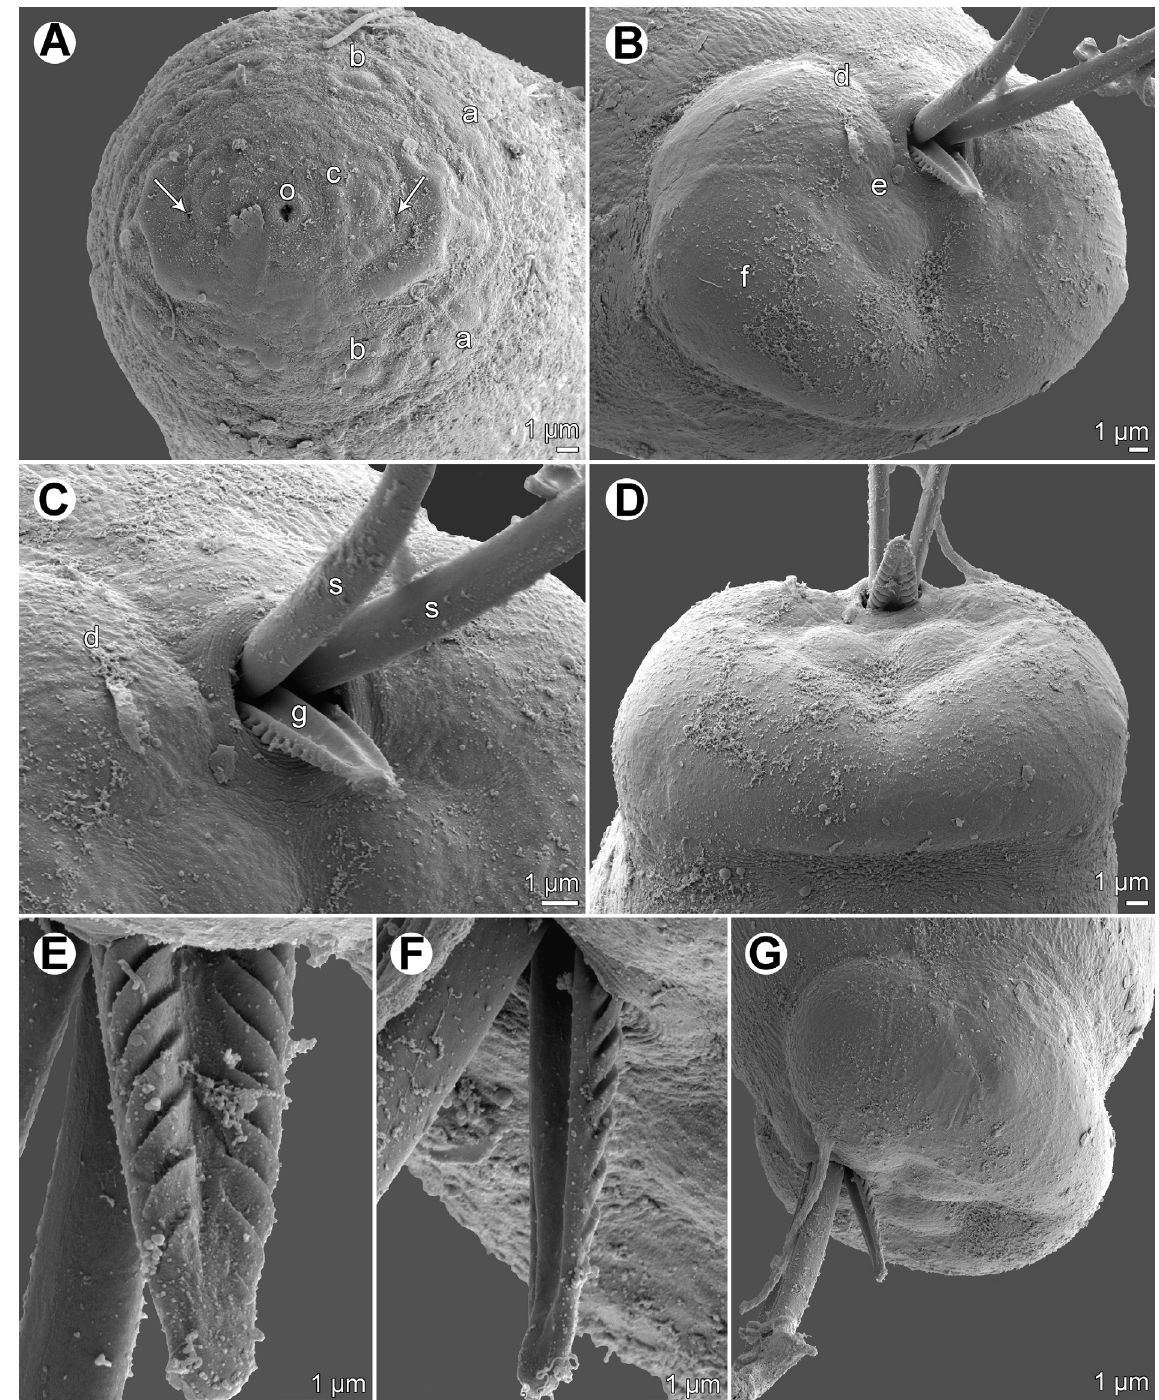
Figure 2. Philometra inexpectata n. sp., scanning electron micrographs of male. A: Cephalic end, apical view (arrows indicate amphids). B: Caudal end, apical view. C: Region of cloaca, ventral view. D: Caudal end, dorsal view. E, F: Distal end of gubernaculum, dorsal and lateral views, respectively. G: Caudal end, lateral view. Abbreviations : a, submedian pair of external cephalic papillae; b, submedian cephalic papilla of internal circle; c, lateral cephalic papilla of internal circle; d, group of four adanal caudal papillae; e, large papilla posterior to cloaca; f, caudal mound; g, gubernaculum; o, oral aperture; s,